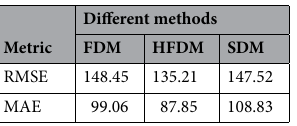
Table 4. Prediction accuracy between different